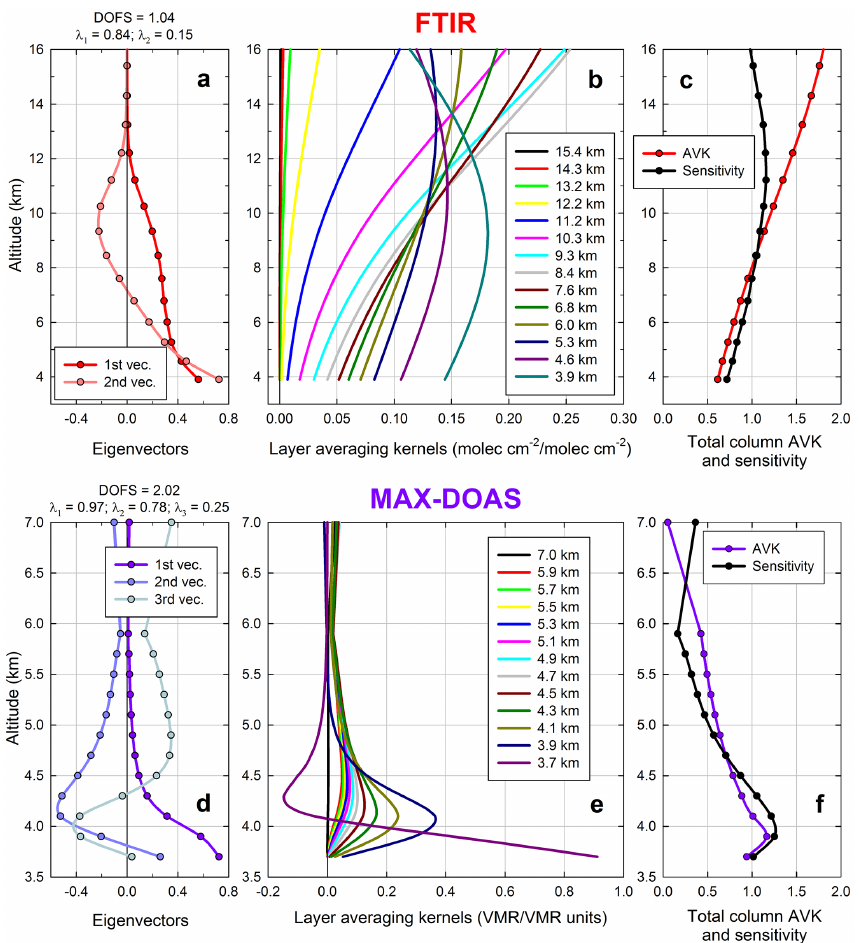
Figure 3. First eigenvectors and the associated eigenvalues ( a and d ), layer averaging kernels ( b and e ) and total column averaging kernel (AVK) and sensitivity profile ( c and f ) characterizing the FTIR (upper frames) and MAX-DOAS (lower frames) retrievals of HCHO above Jungfraujoch. Note that the layer averaging kernels are expressed in moleccm − 2 (moleccm − 2 ) − 1 for FTIR and in VMR/VMR units for MAX-DOAS. These information parameters have been calculated on the basis of all the individual profiles retrieved over the July 2010– December 2012 time